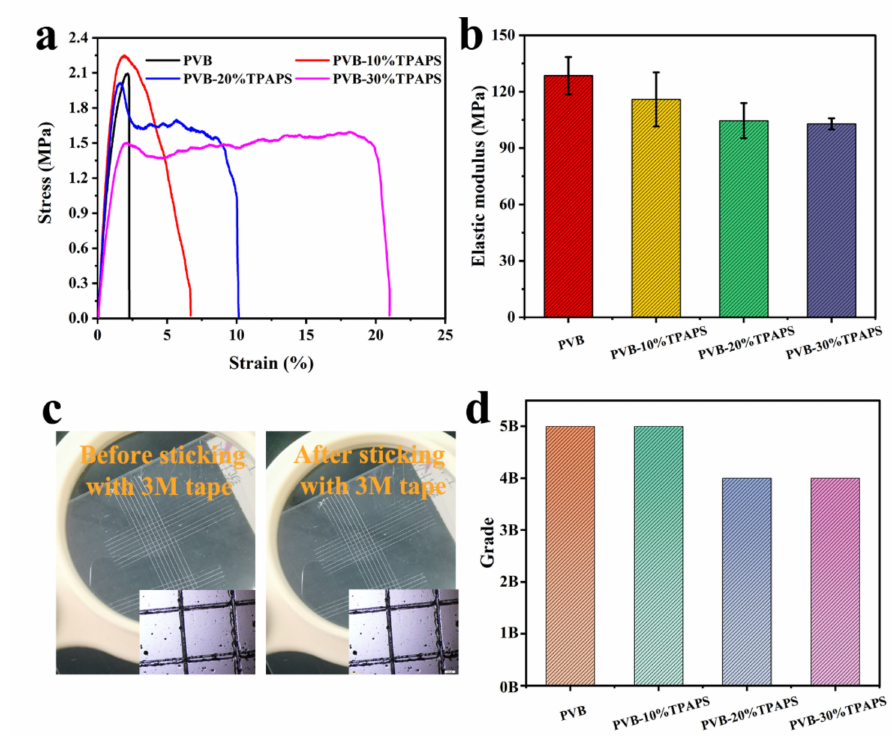
Figure 5. The mechanical properties and adhesion determinations of the coatings by a cross-cut test. ( a ) The stress–strain curves and ( b ) their corresponding elastic modulus. ( c ) Digital photographs of the PVB-10%TPAPS coating before and after peeling with 3M tape, the bottom right of the image is the microscope photo of the grid. ( d ) Corresponding statistical chart of the adhesion classification of PVB-X% TPAPS